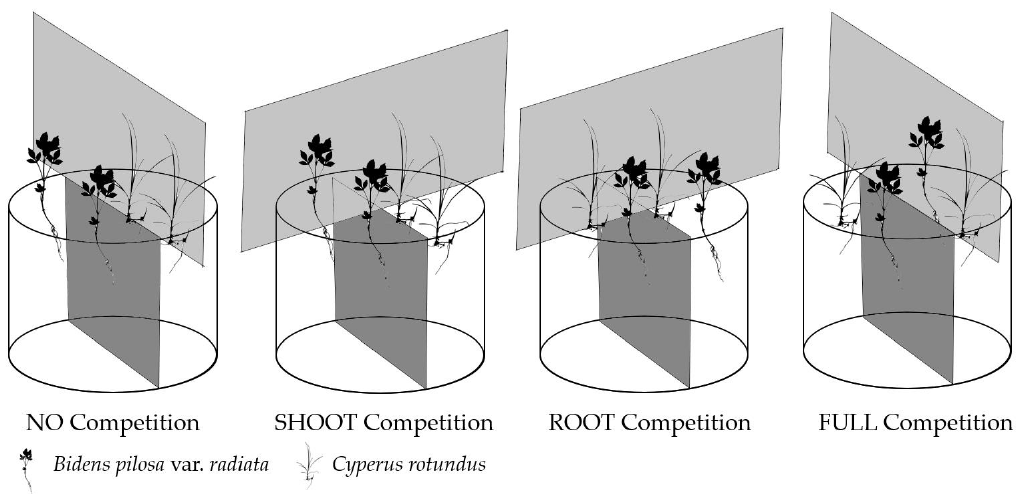
Figure 7. The design of the interspecies competition experiment. The relative arrangement of aboveground and belowground partition and the disposition of two plants were designed to give four modes of competition (i.e., NO, SHOOT, ROOT and FULL